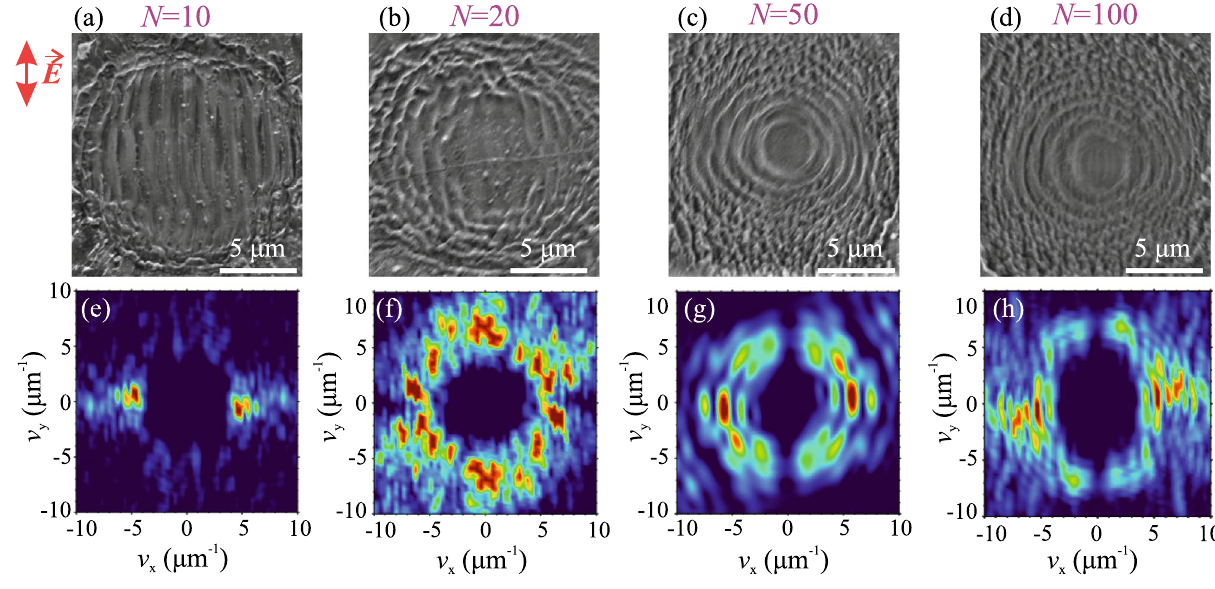
spatial frequency spectra retrieved by